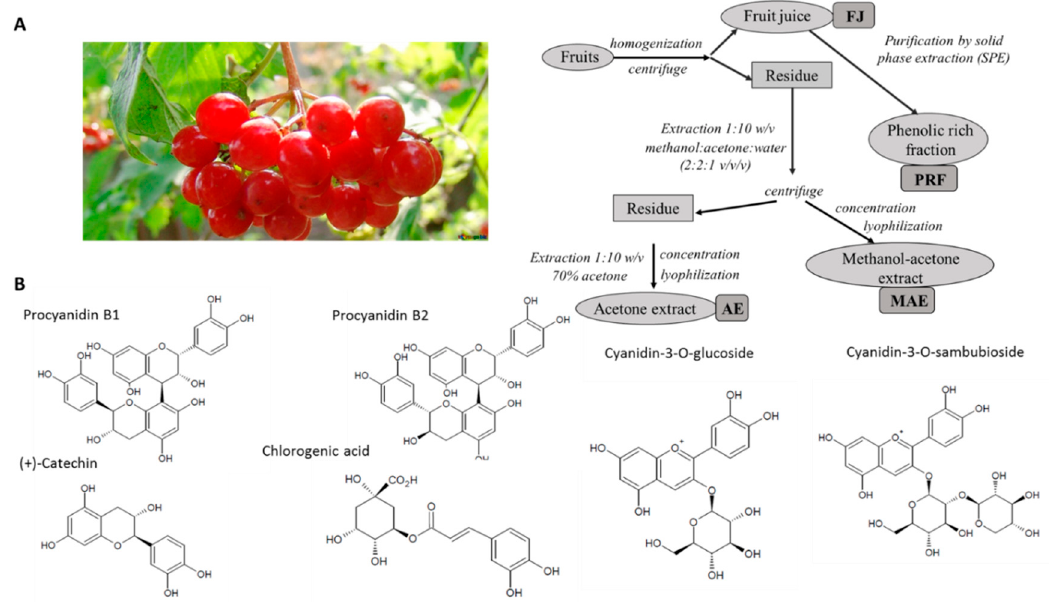
Figure 1. Viburnum opulus fruit as source of phenolic compounds. ( A ) Schematic diagram of V. opulus